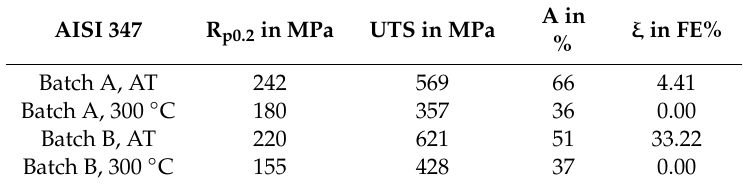
Table 2. Mechanical properties and α ’-martensite content after specimen failure ( ξ ).